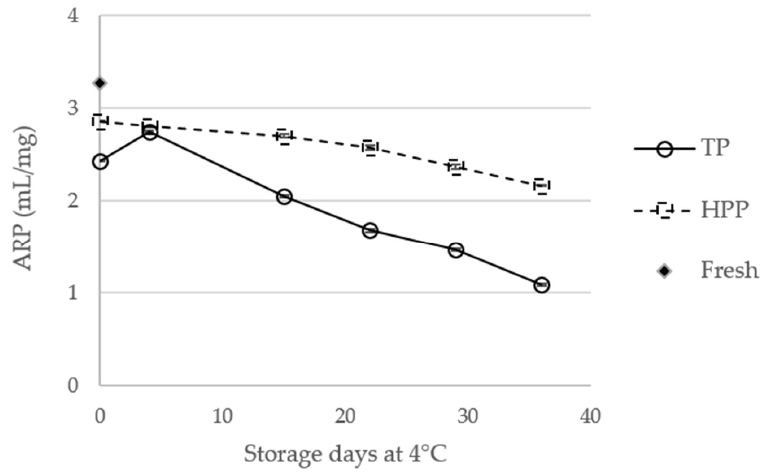
Figure 8. Antioxidant activity, expressed as antiradicalar power (ARP, mL/mg), of fresh orange juice and thermal pasteurized (TP) and high-pressure processed (HPP) orange juices during storage.